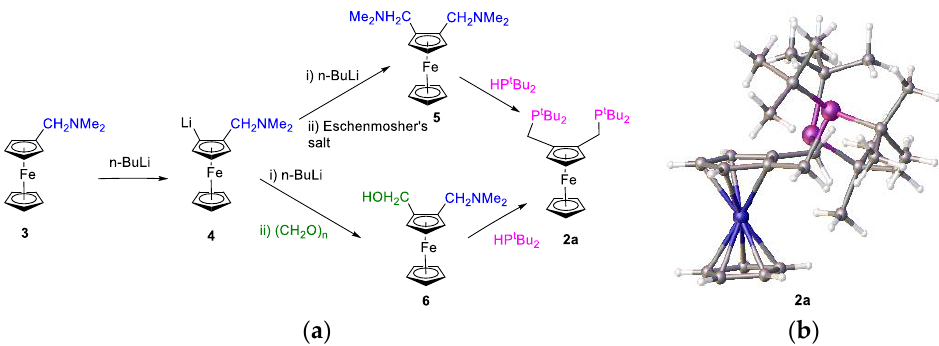
Figure 6. ( a ) Synthetic route to 1,2-bis-[di-( tert -butyl)phosphano)] ferrocene, butphos , 2a , and ( b ) a view of the crystal structure of 2a .